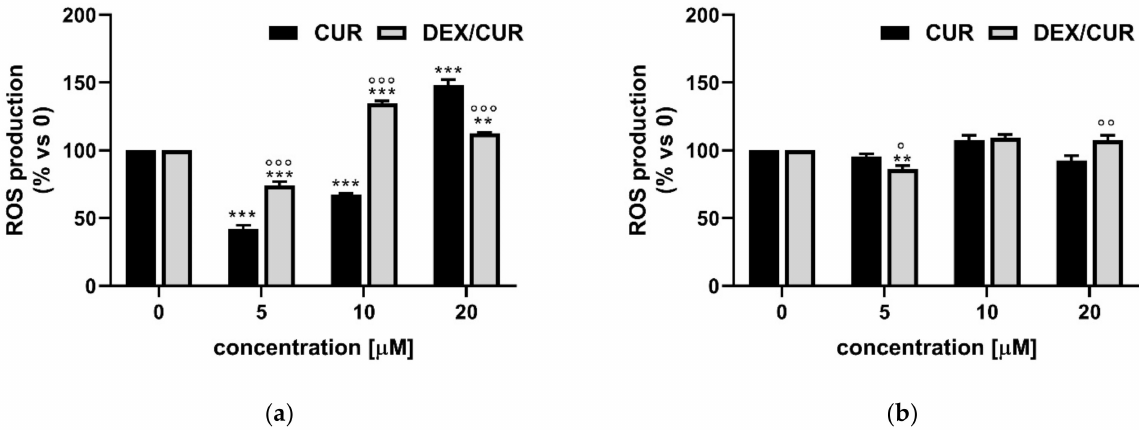
Figure 6. ROS levels (expressed as % of ROS production compared to the control) determined by FACS analysis using the CM-H2DCFDA probe in ( a ) PC-3 and ( b ) PNT-2 cells after 48 h treatment with CUR and DEX/CUR (5, 10, and 20 CUR equivalent concentration). Data were reported as mean values ± SD of three independent experiments. Two-way ANOVA followed by Dunnett’s method: ** p < 0.001, *** p < 0.0001 vs. control. ◦ p < 0.01, ◦◦ p < 0.001, ◦◦◦ p < 0.0001 vs. CUR equivalent